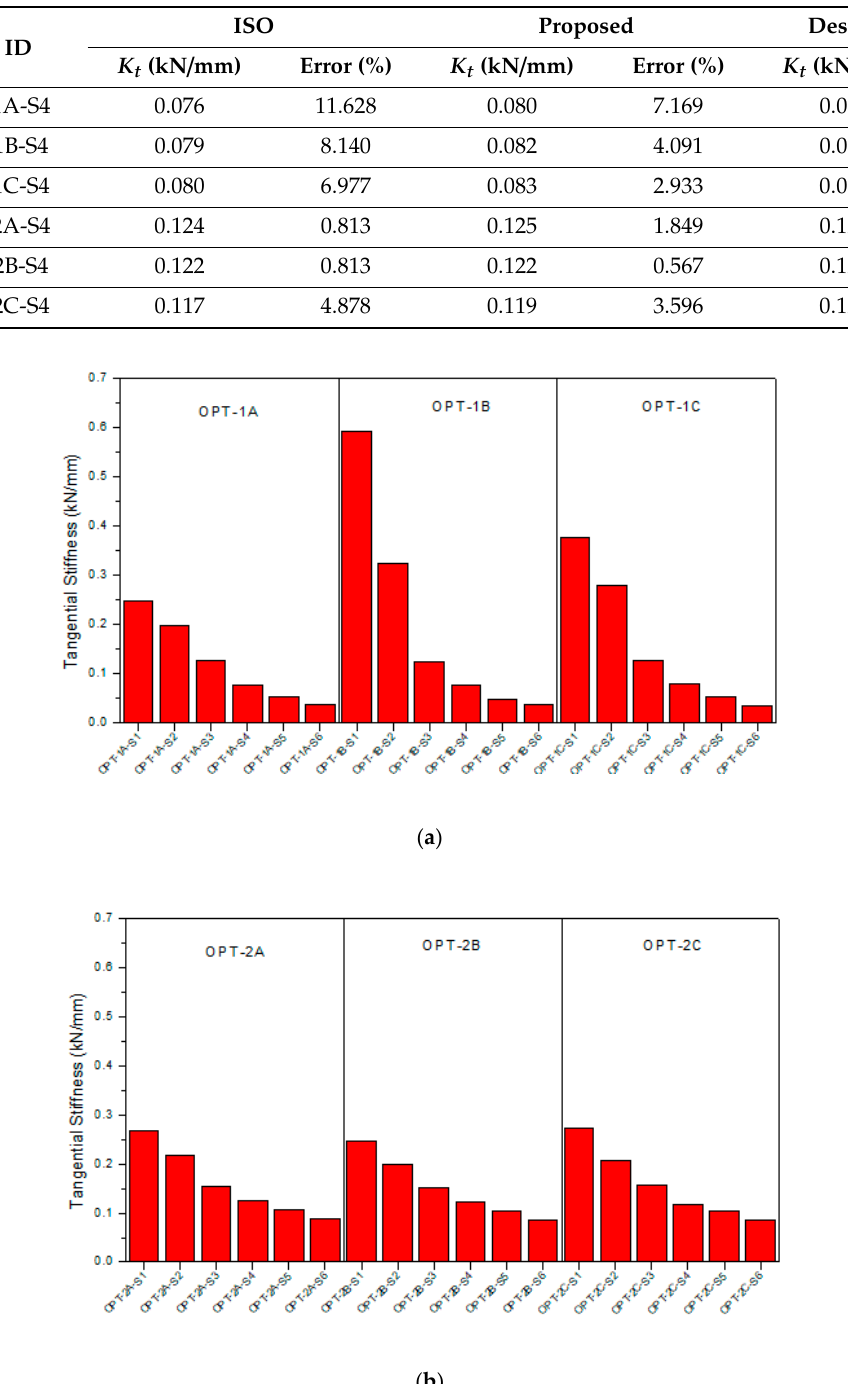
Figure 14. Determined tangential stiffness from test data: ( a ) OPT-1; ( b ) OPT-2.